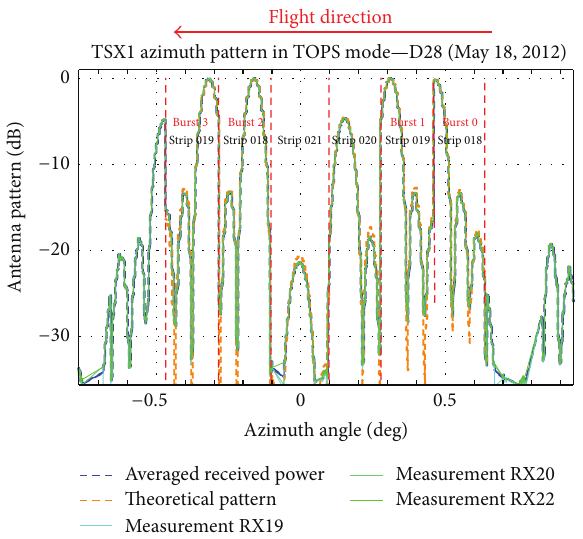
Figure 3: Comparison of the normalized TOPS azimuth pattern measuredbyGRsduringoneoverpassandthereconstructedpattern derived from the antenna model. Only the relevant azimuth angles corresponding to bursts 0-1-2-3 are